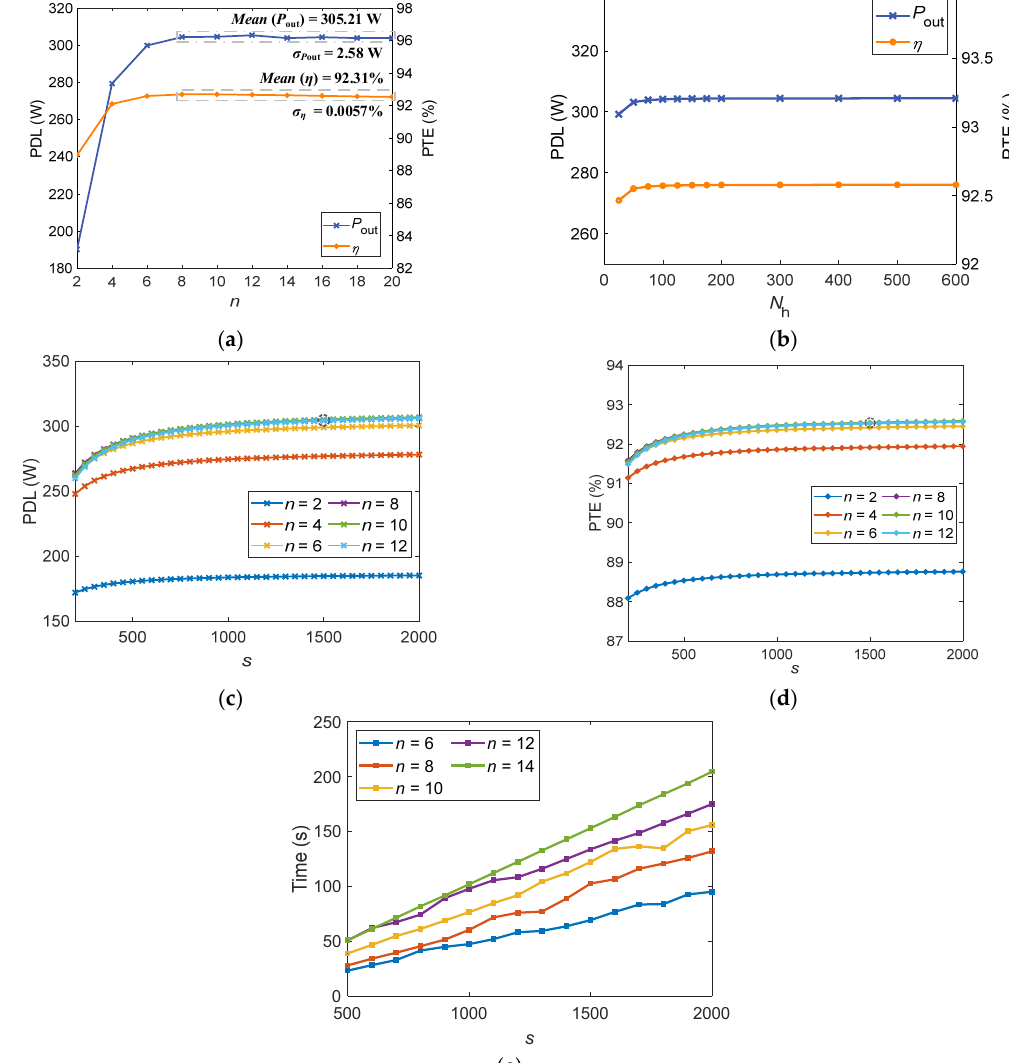
Figure 4. The impact of hyperparameters on calculated values of power delivered to the load (PDL) and power transmission efficiency (PTE): ( a ) PDL and PTE on different n when coils are coaxial; ( b ) PDL and PTE on different N h when coils are coaxial; ( c ) PDL on different n and s when coils are noncoaxial; ( d ) PTE on different n and s when coils are noncoaxial; ( e ) Computing time of the calculation model on different n and s when coils are noncoaxial.